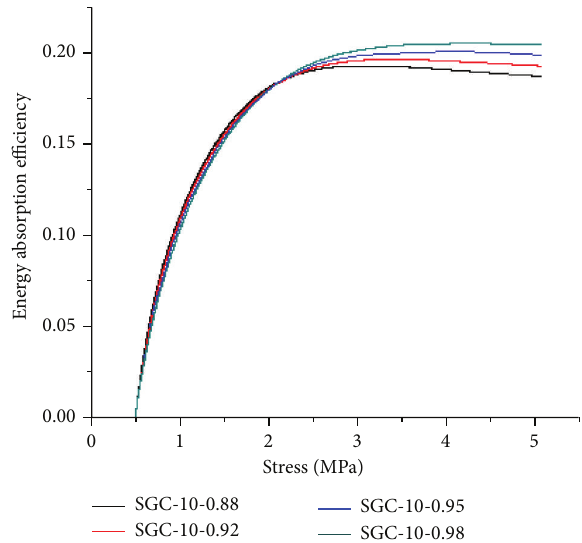
Figure 13: Energy absorption efficiency of the WTDCEs.